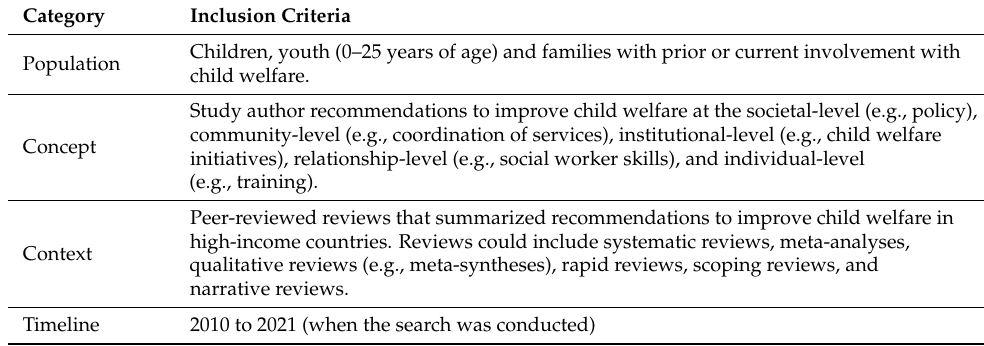
Table 1. Inclusion criteria.